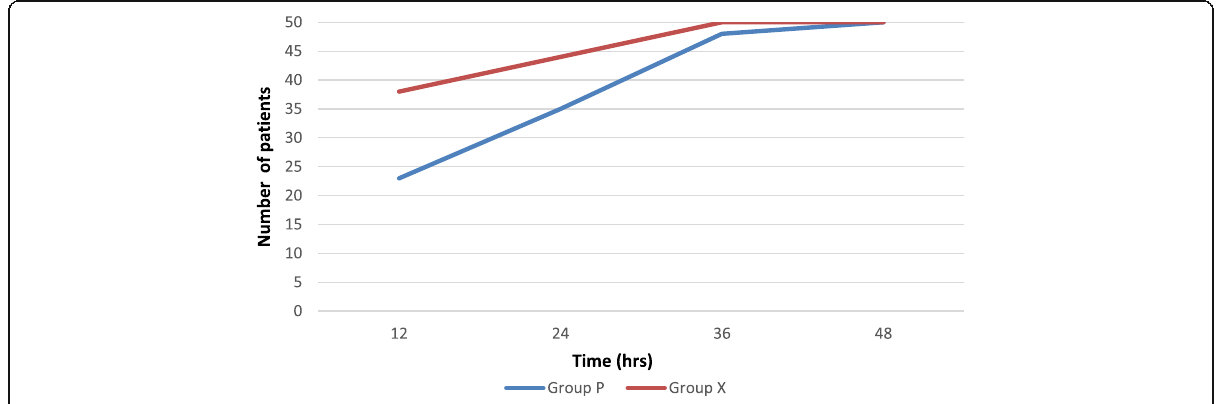
Fig. 1 Comparison between the two groups as regards the number of patients who reached therapeutic level over time